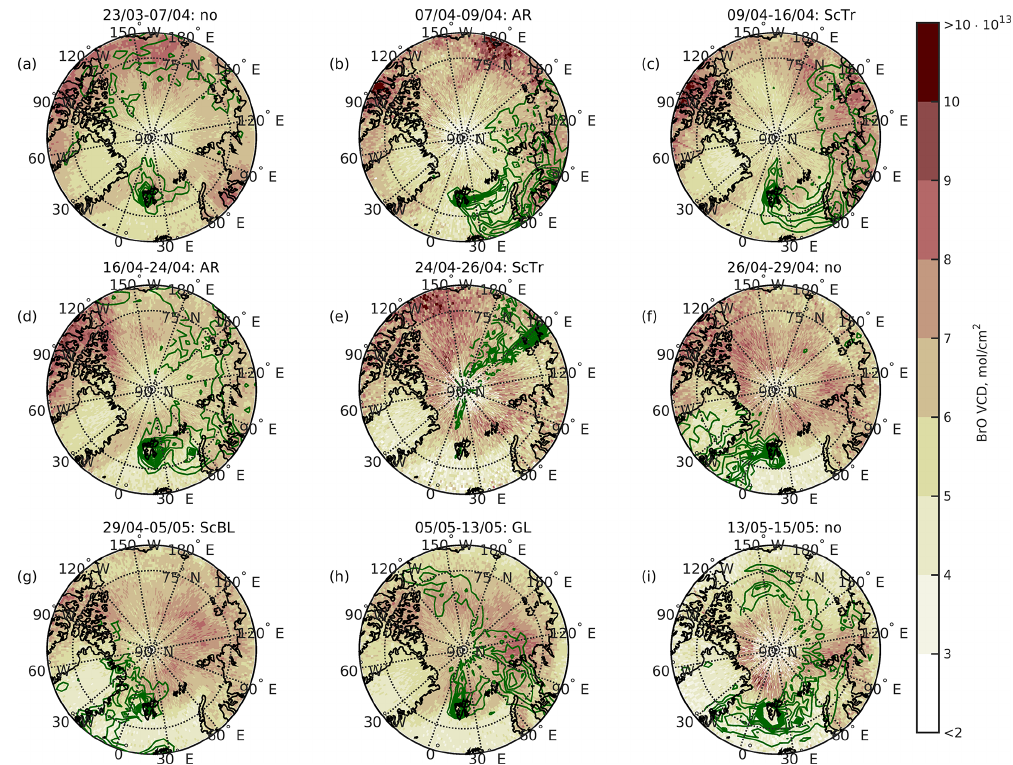
Figure 9. FLEXPART trajectory probability for 10d backward trajectories (dark green contours with step of 0.001) and GOME2 BrO vertical column density (VCD) (colour scale) for the different sub-periods. The percentage of trajectories descending from higher altitudes ( > 2000m) is 7%, 12%, 27%, 9%, 9%, 33%, 18%, 4% and 24% for the sub-periods in (a) – (i) ,